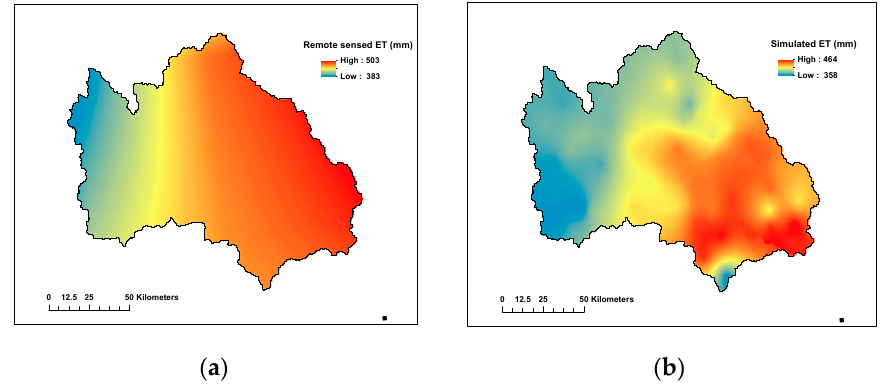
Figure 5. The spatial distribution of the annual mean ET during 1983–2006. ( a ) Remote sensed; ( b ) SWAT simulated.